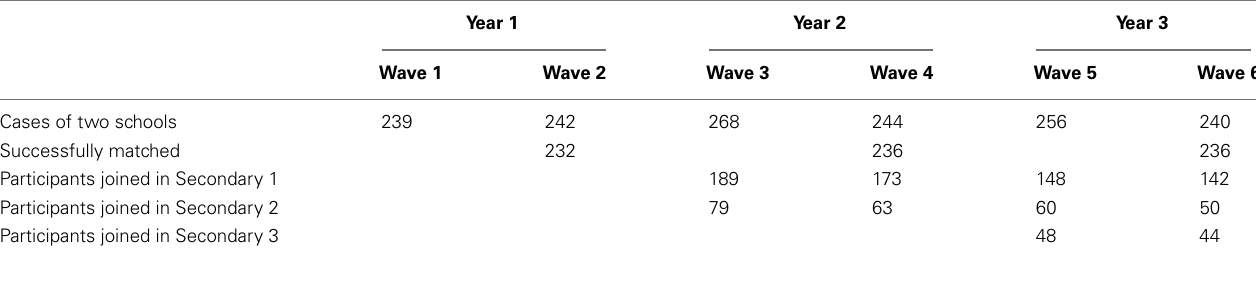
Table 1 | Number of participants and completed questionnaires collected in year 1 (Wave 1 and 2), year 2 (Wave 3 and 4), and year 3 (Wave 5 and 6)